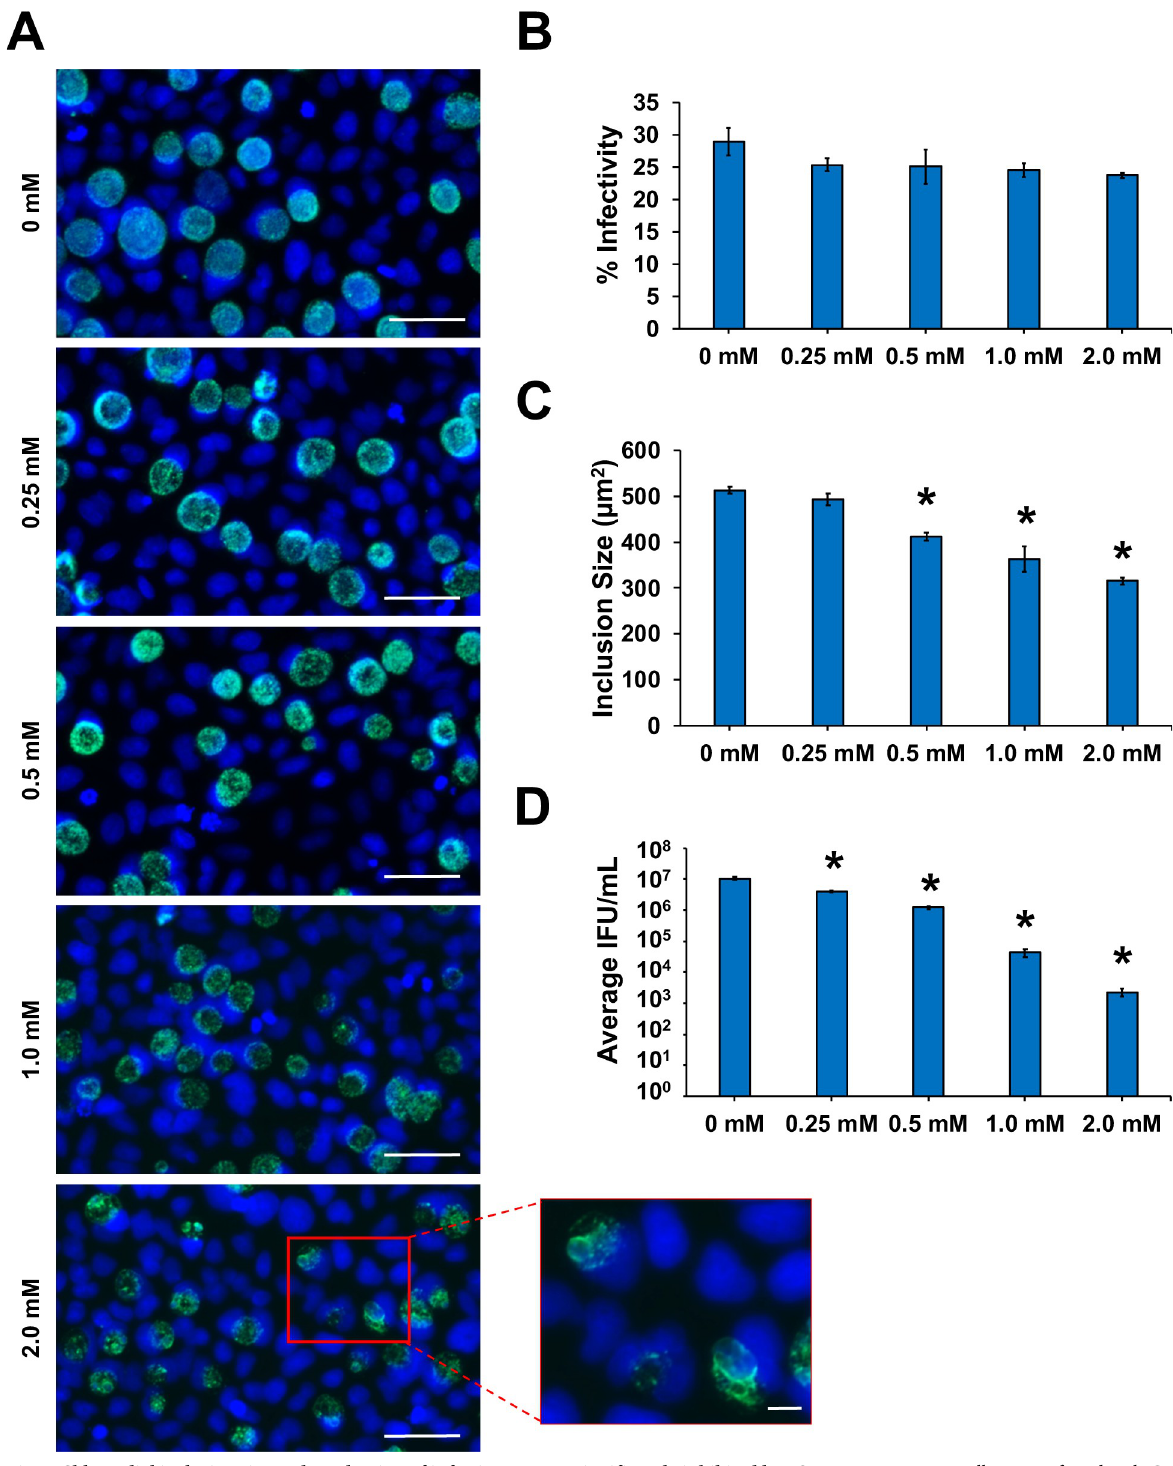
Fig 5. Chlamydial inclusion size and production of infectious EB are significantly inhibited by FSM exposure. HeLa cells were infected with C . trachomatis at an MOI of 0.5 and harvested for analysis at 40 hpci. (A) Representative 400X magnification fluorescence microscopy images of chlamydial inclusions (green) stained with BioRad anti-chlamydial LPS Pathfinder stain and HeLa cell nuclei (blue) counter-stained with DAPI. Scale bars = 50 μ m. Insert from 2 mM FSM concentration depicts zoomed-in view of ABs. Scale bars = 10 μ m. (B) Percent infectivity was calculated by counting the number of inclusions/cell nuclei per field in 10 fields per coverslip in triplicate samples. (C) The area of 150 random inclusions per